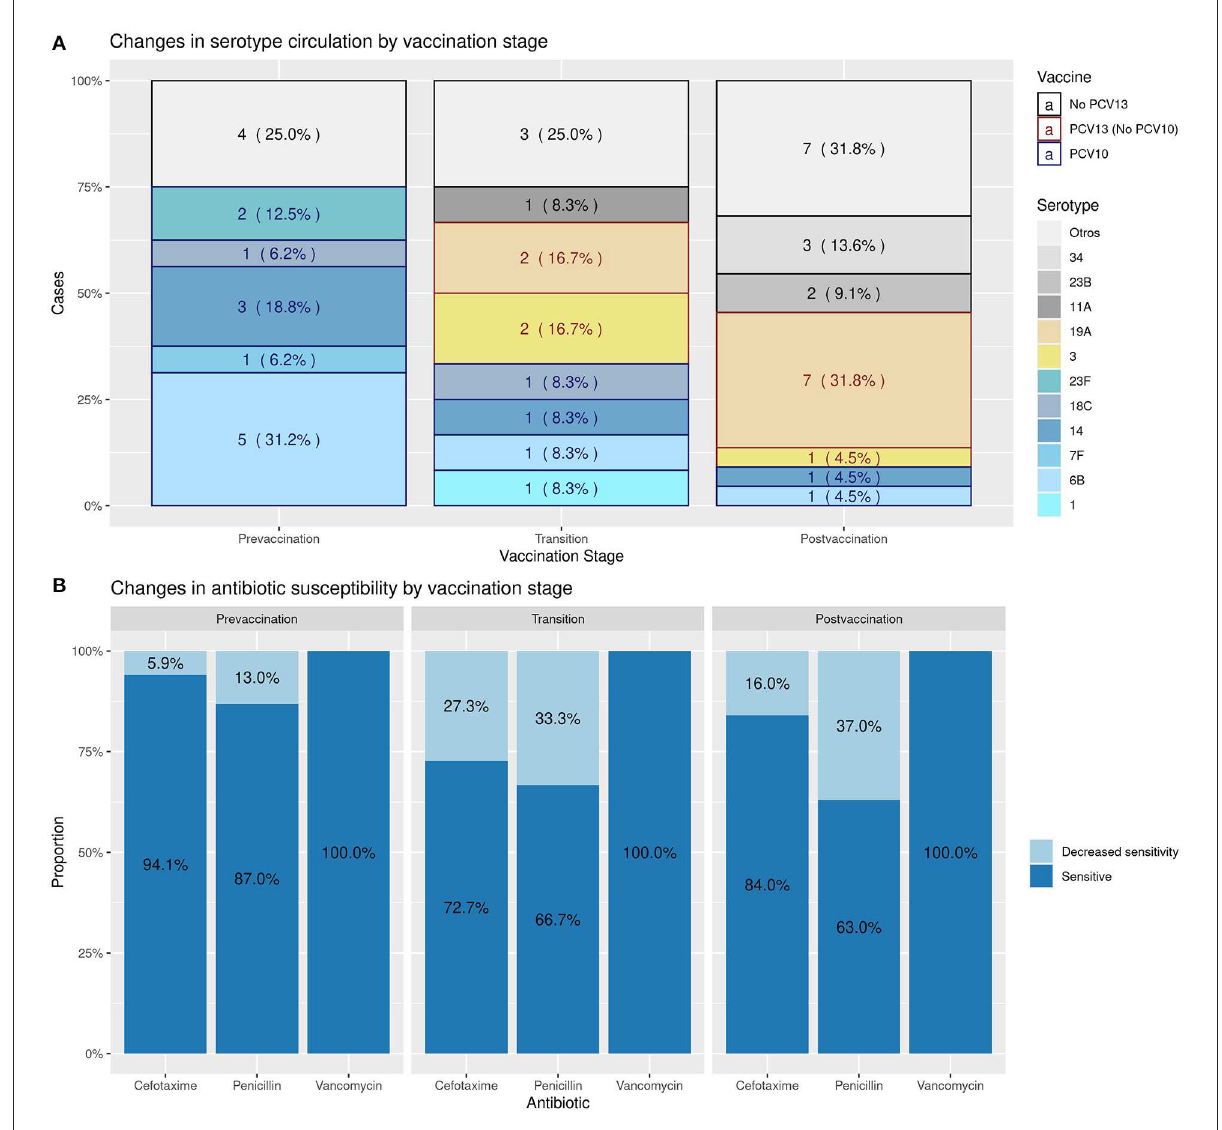
FIGURE2 Changes in the circulation of serotypes and in bacterial resistance according to the vaccination